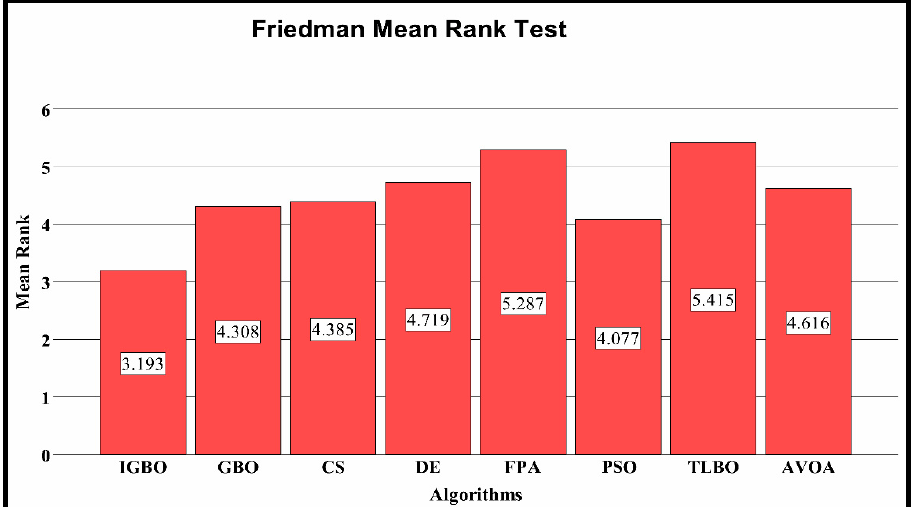
Figure 6. Friedman Mean rank test for multimodal functions.